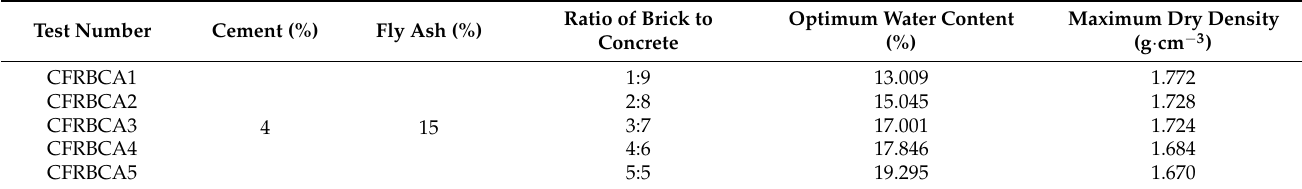
Table 4. Physical indexes of reclaimed gravel for brick and concrete.